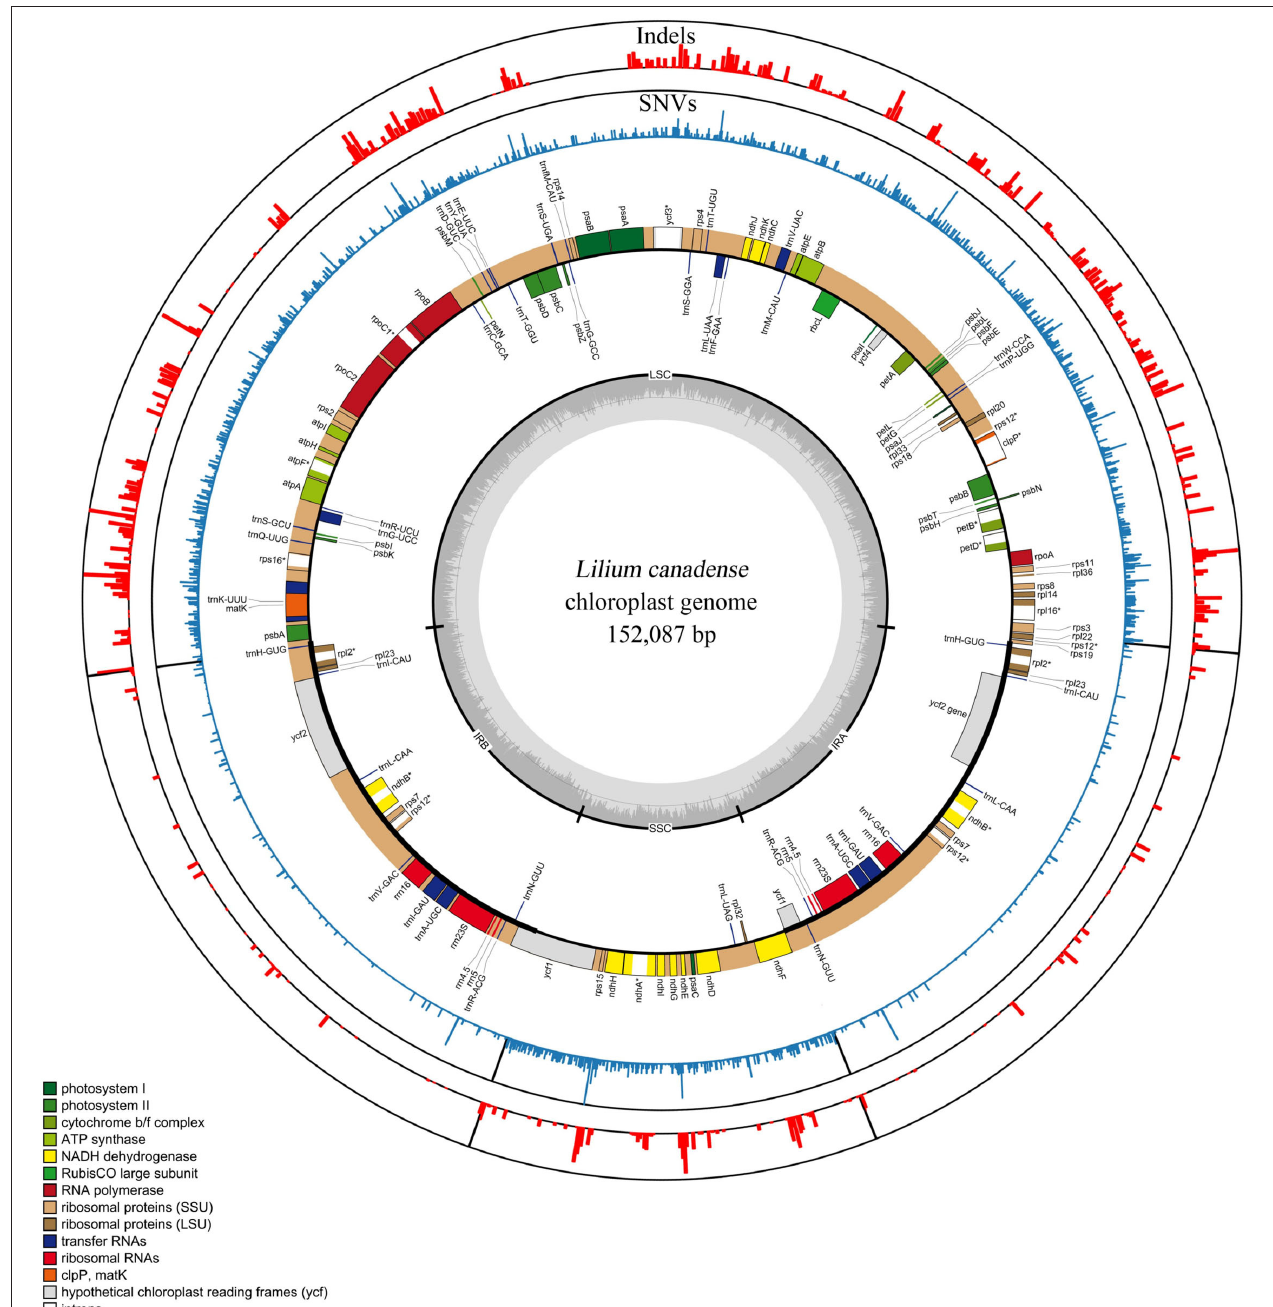
FIGURE 1 | Genomic map and variations of the genus Lilium represented over a circular map of the Lilium canadense plastome. SNVs and indels are shown in red and blue in the outer layers, and the genomic map is shown in the inner layer. The frequency of the SNVs and indels is represented by the height of the colored bars. Genes shown on the outside of the genomic map are transcribed clockwise and those inside are transcribed counterclockwise. Gene functional groups are